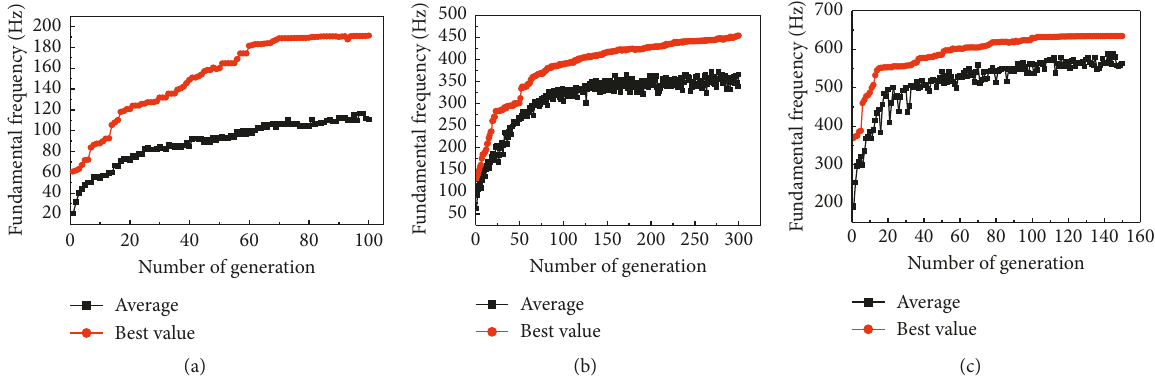
Figure 13: MIGA evolution with increased numbers of variable control points (Approach 1). (a) Shell 1. (b) Shell 2. (c) Shell 3.